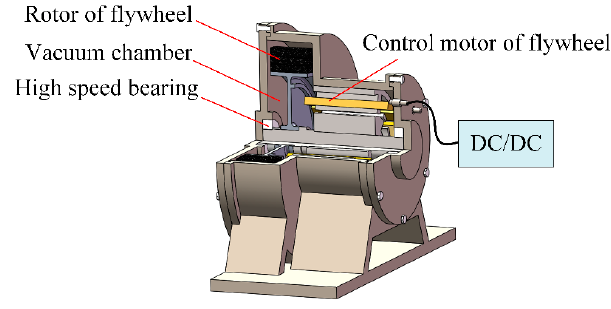
Figure 1. Schematic diagram of flywheel battery structure.